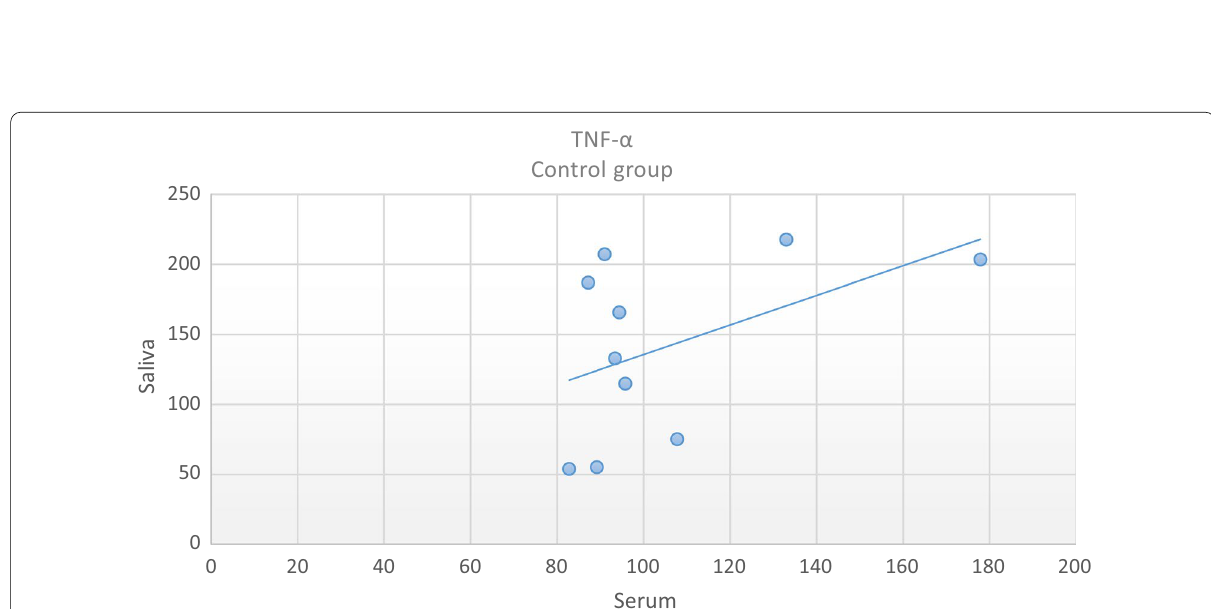
Fig. 9 Correlation between serum and saliva TNF-α expression in control group as determined by Pearson’s correlation coefficient